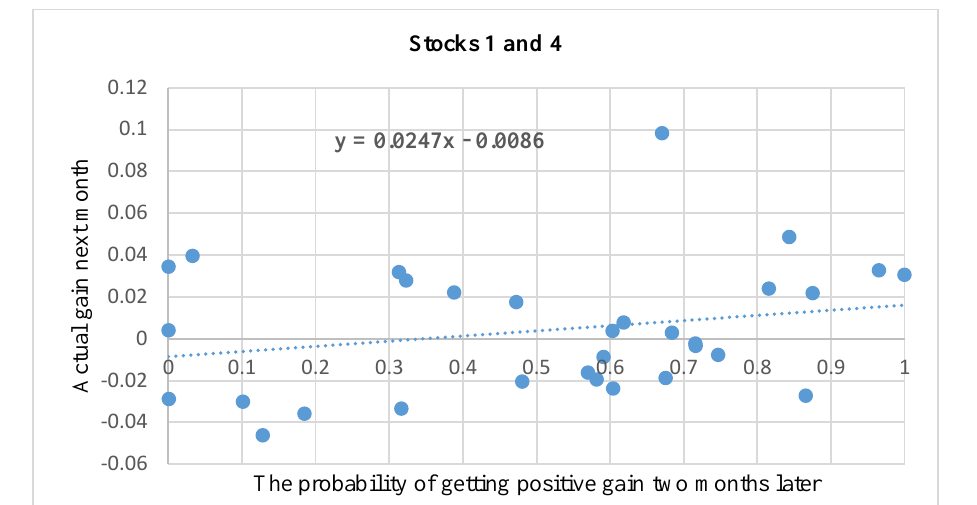
Fig. 2. The results of the regression of actual gain next month on the probability of getting positive gain two months later when stocks 1 and 4 are used.